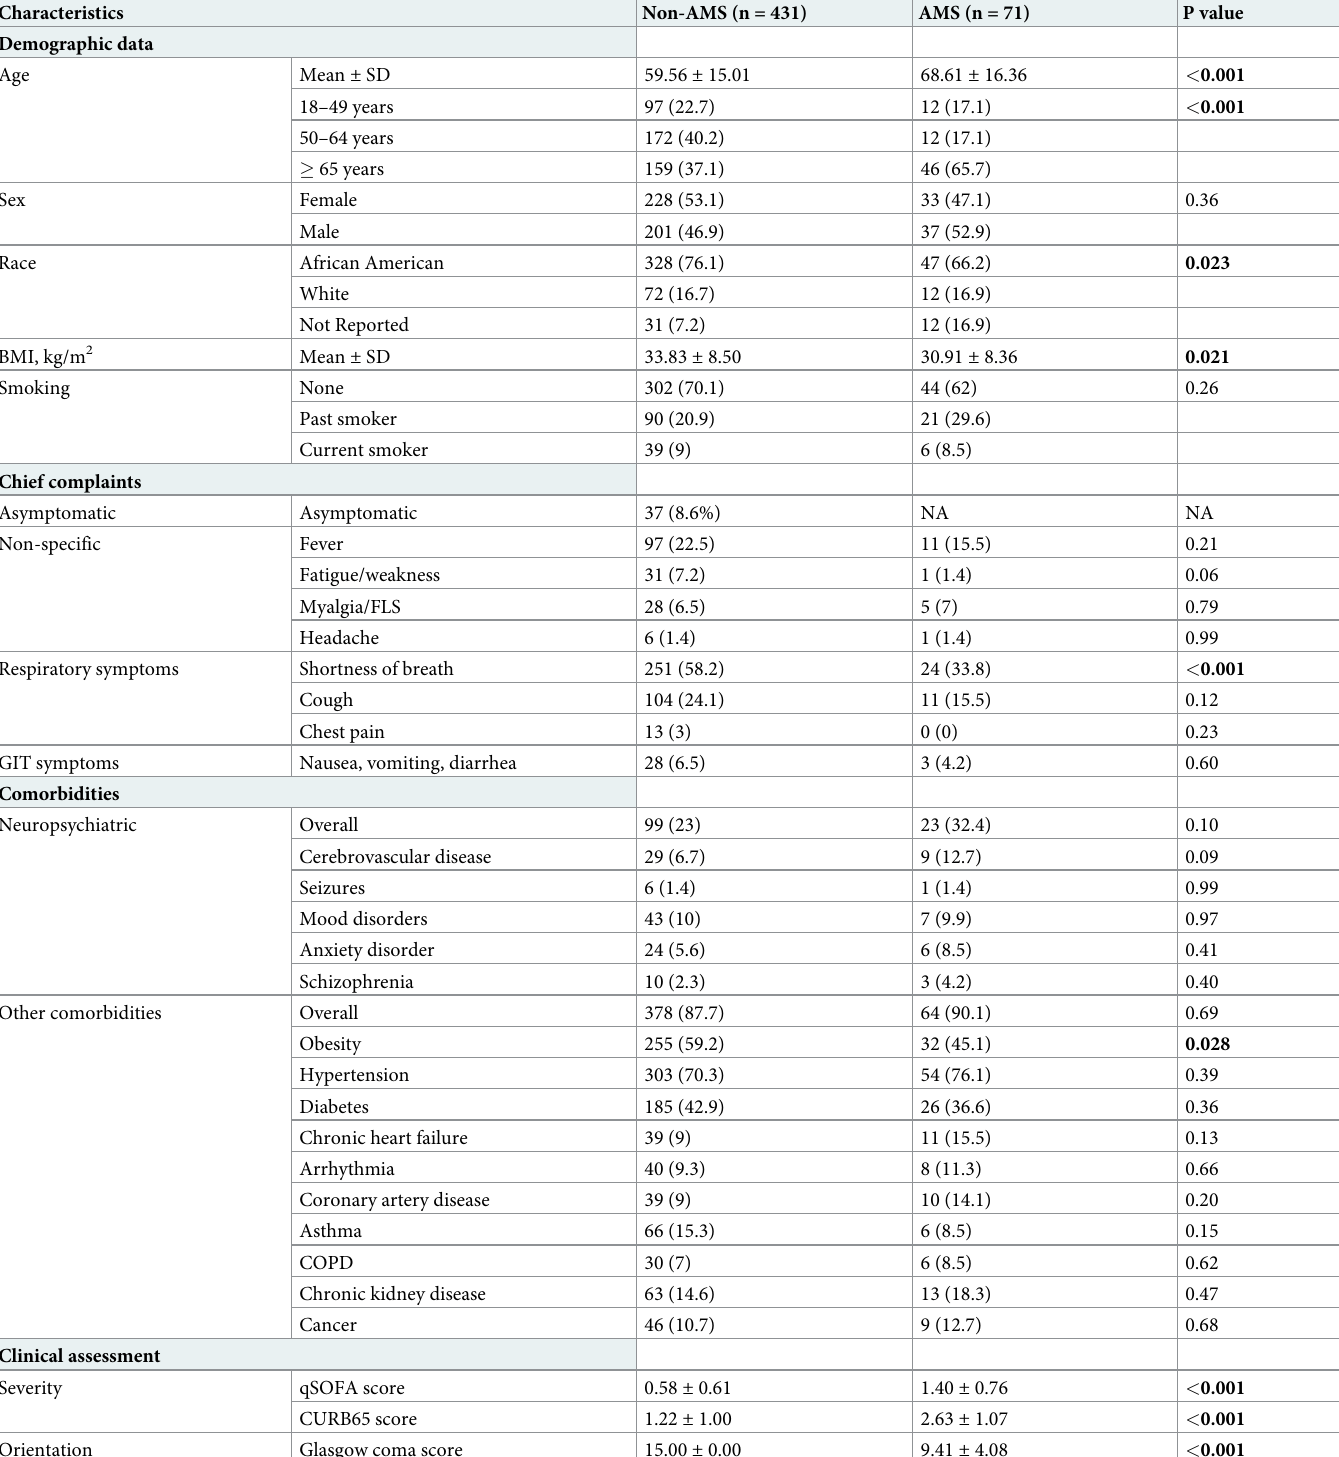
Table 1. Characteristics of COVID-19 patients at admission.